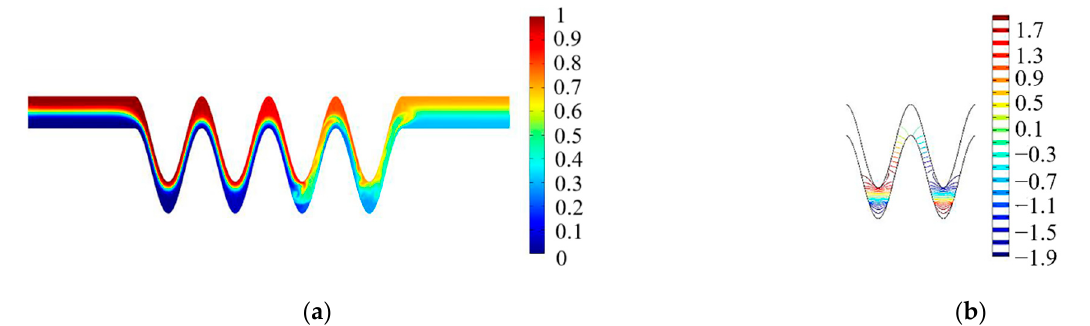
Figure 6. Model validation based on Siyue Xiong et al. [33] ( a ) comparison of the mixing index for different Re numbers, ( b ) comparison of the mixing index for different voltages.